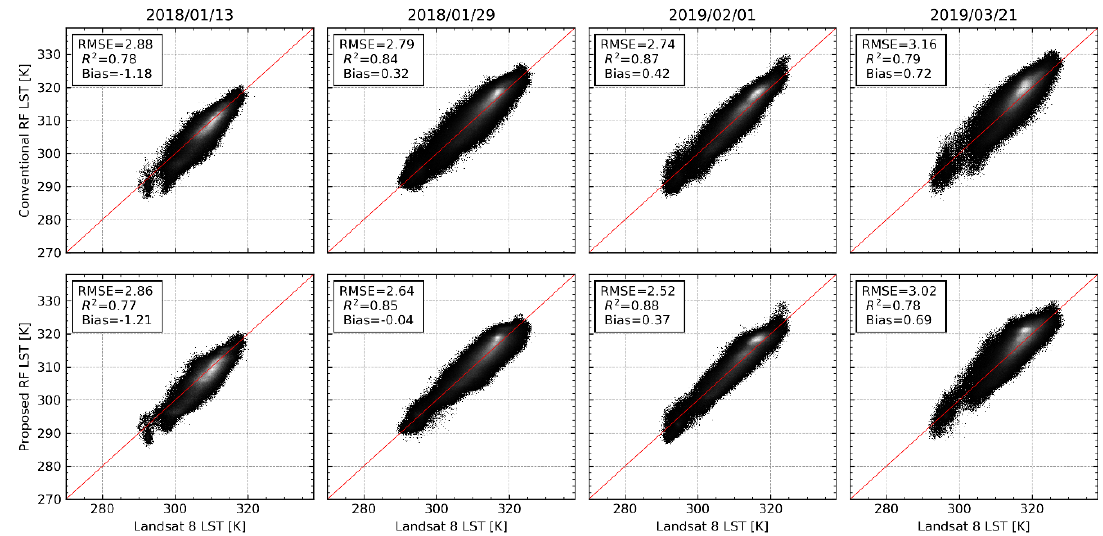
Figure 9. Relationship between Landsat 8 LST and the downscaled LST based on the two approaches for each day corresponding to the four Landsat 8 overpass dates used in the study.